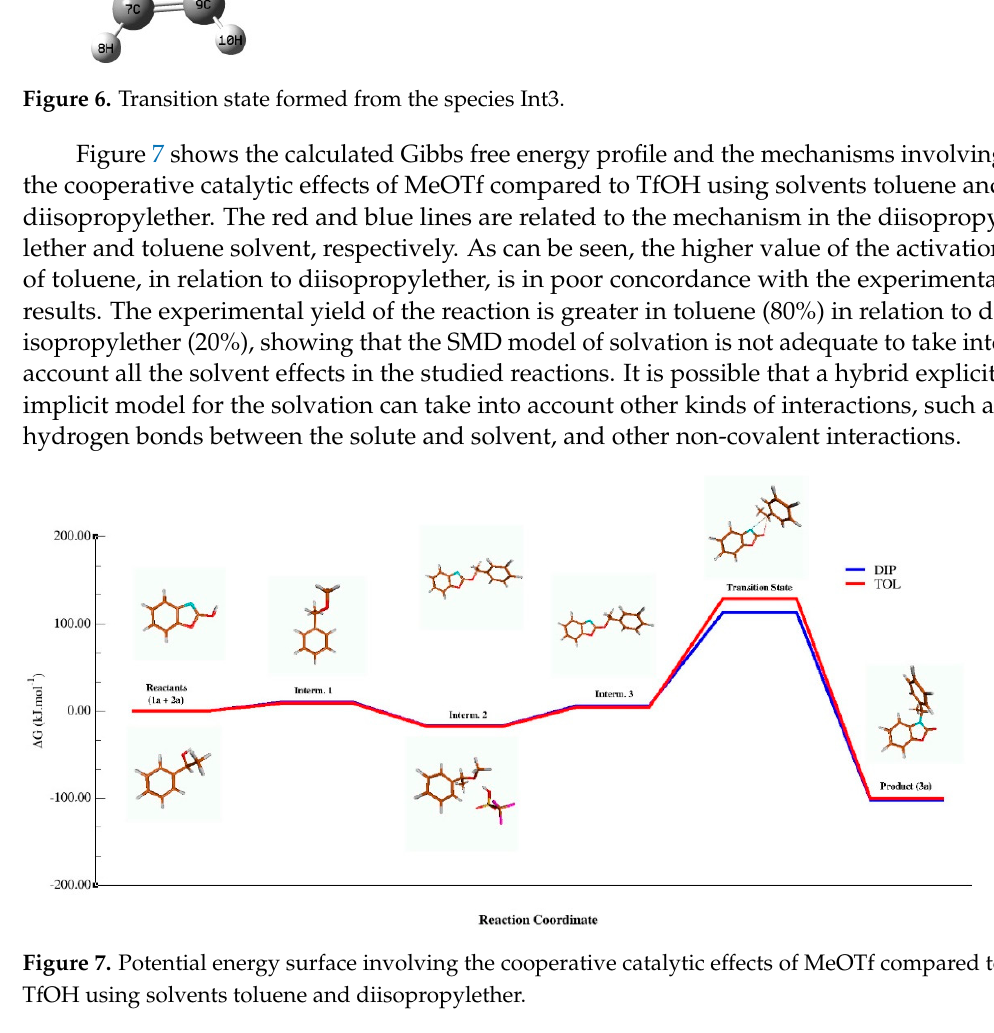
Figure 6. Transition state formed from the species Int3.